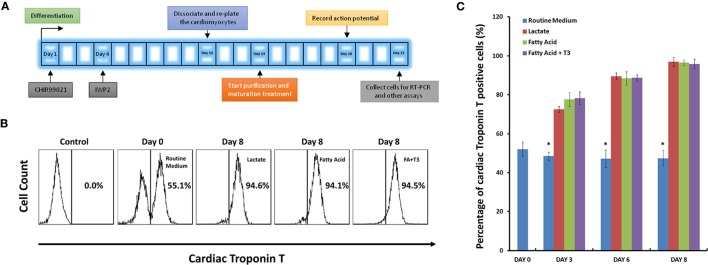
High purity of cardiomyocytes can be obtained under glucose-depleted and fatty acid (with or without T3)-supplemented conditions. (A) The schematic for purification and maturation using metabolic selection. Glycogen synthase kinase 3 inhibitor CHIR99021 and Wnt pathway inhibitor IWP2 (gray boxes) were added to the differentiation medium on differentiation days 1 and 4, respectively. On differentiation day 10, cells were dissociated and plated on glass cover slips. After 3 days recovery, cells were cultured with metabolic selection medium (No-glucose DMEM medium supplemented with lactate, fatty acid, and fatty acid + T3). On differentiation day 18, cells were collected for patch clamping experiments. On differentiation day 21, cells were collected for other experiments. (B) Representative fluorescence-activated cell sorting (FACS) analyses of cardiac Troponin T expression in the human pluripotent stem cell (hPSC)-derived cells on day 0 with routine culture medium, and on day 8 with metabolic selection medium. In the control group, the isotype control (mouse IgG) was used instead of the primary antibody. (C) Time courses of selection efficiency using the lactate-supplemented condition (red), the fatty acid-supplemented condition (green), and the fatty acid with T3-supplemented condition (purple); cells cultured with routine medium (blue) were set up as the control groups (n = 3). The asterisk means each test group is significantly different from controls, P < 0.01.